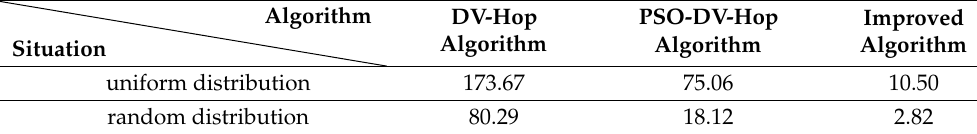
Table 2. The standard deviations of different